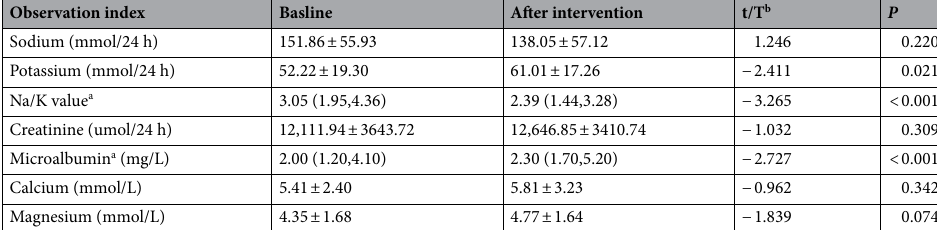
Table 2.. 24-h urine test results (n = 39). a Non-positive distribution data are expressed in median and quartiles, and Wilcoxon Signed Rank Test was used. b t for the statistic of the Paired T Test, and T for the statistic of the Wilcoxon Signed Rank